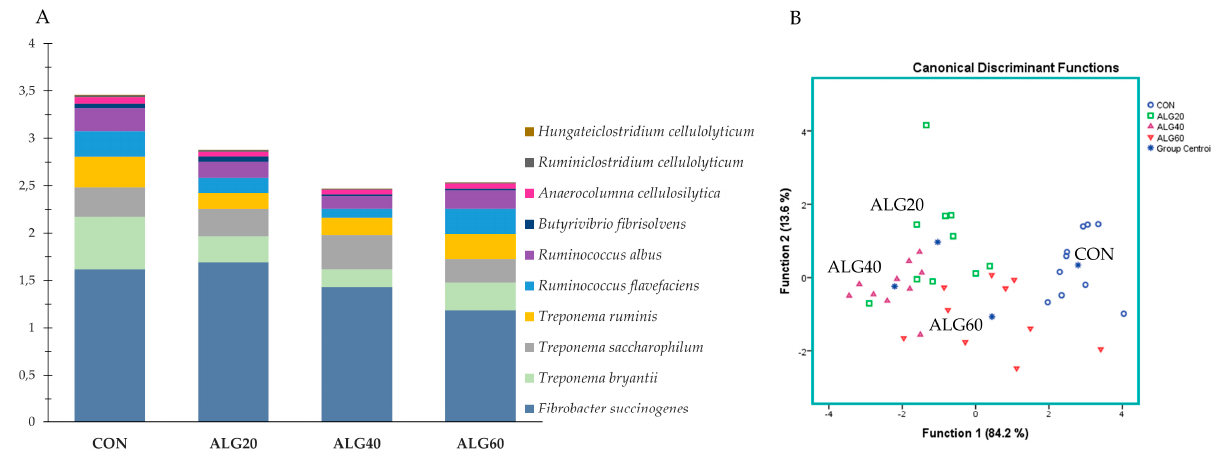
Figure 6. ( A ) Abundances of the most representative cellulolytic species in the four dietary treatments (CON, ALG20, ALG40, and ALG60) within the two sampling times (20th and 40th days) illustrated in clustered stacked columns. ( B ) Discriminant plots separating the four dietary treatments (CON, blue ○ ; ALG20, green □ ; ALG40, purple △ ; and ALG60, red ▽ ) according to the pooled data of the two sampling times (20th and 40th experimental days) entered together as independents on the abundances of the ten principal species with cellulolytic activity in the goats’ rumen. CON = control concentrate without microalgae ( Schizochytrium spp.); ALG20 = CON with 20 g/Kg Schizochytrium spp.; ALG40 = CON with 40 g/Kg Schizochytrium spp.; ALG60 = CON with 60 g/Kg Schizochytrium spp.